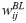
Evidence for PGs responding selectively to word “one” or “two” in the A1 layer of the trained AN-CN-IC-CX model.Each plot shows an example of a stable spatio-temporal spike pattern in A1 (red circles) in response to different pronunciations of the words “one” (left) and “two” (right). These spikes take part in at least one polychronous group that is selective for the particular word. In other words, these patterns are more likely to appear when an example of their preferred word is pronounced compared to an example of a non-preferred word. When projected through the A1→Belt connections (wijBL) with different conduction delays (Δij) (arrows), these patterns produce near-synchronous input from several A1 neurons onto a subset of Belt neurons (green, yellow or white circles corresponding to three separate Belt neurons with different distributions of axonal conduction delays Δij). The green and yellow circles show such inputs for two Belt neurons which in this manner respond selectively for a number of different pronunciations of the word “one”, the white circles show inputs for a neuron that responded selectively to exemplars of the word “two”. Abscissa represents the time window Δt = tj ± 50 ms around the origin. The origin is centered around all the times t when a chosen A1 neuron j fires (see Section Polychronization Index for details). Ordinate represents the 1000 neurons that make up A1 in the AN-CN-IC-CX model. Red circles show the ten elements of the firing pattern matrix Msj with the largest mean spike counts (msj)n (see Section Polychronization Index for details).